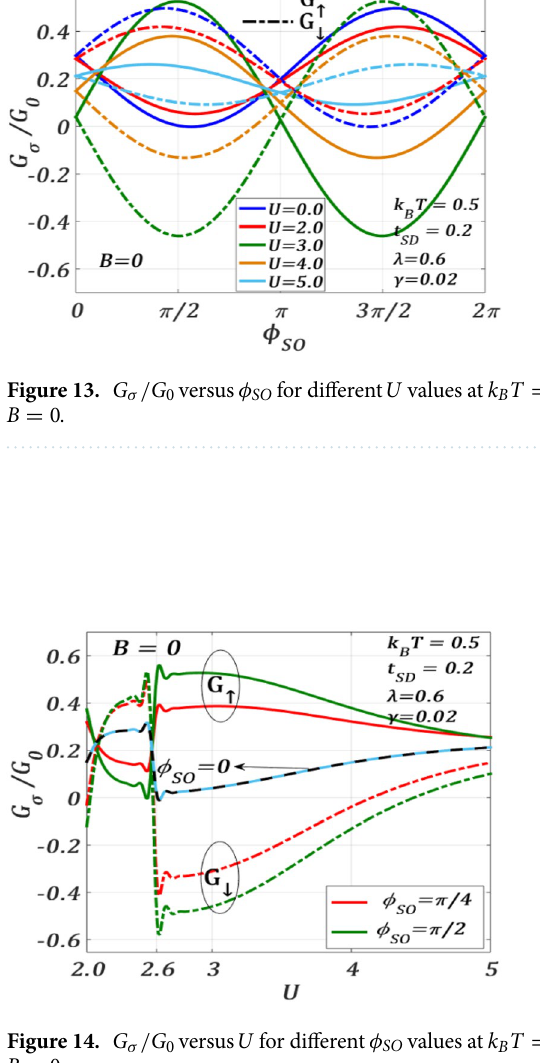
Figure 14. G σ / G 0 versus U for different φ SO values at k B T 0 B =